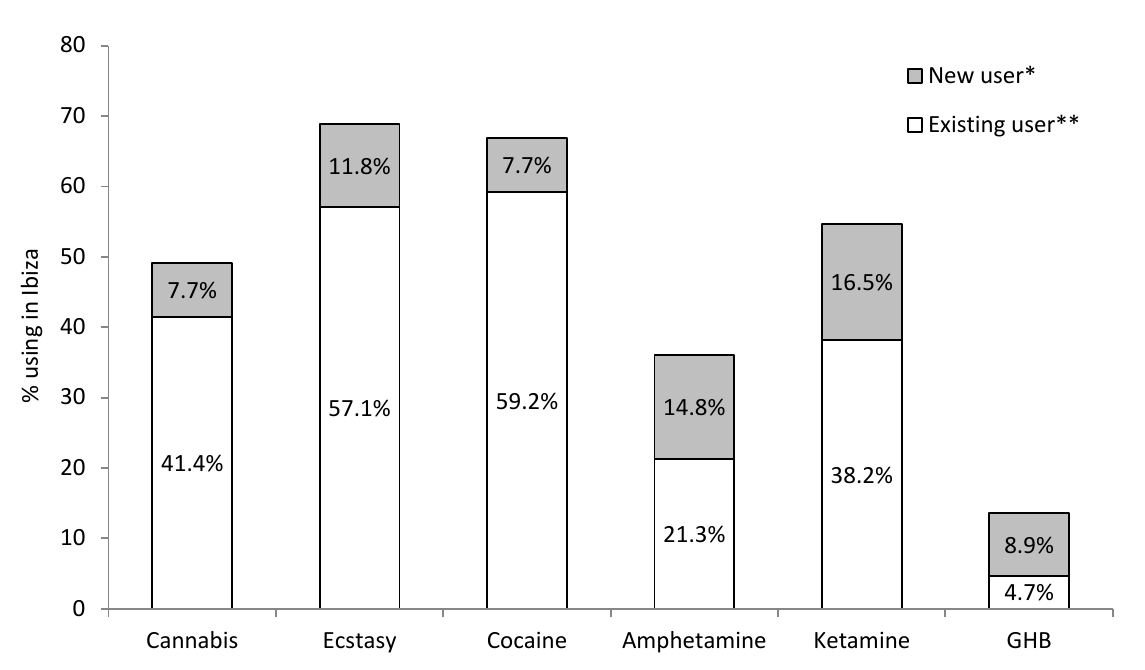
Figure 1. Prevalence of illicit drug use by casual workers in Ibiza, by new and existing drug